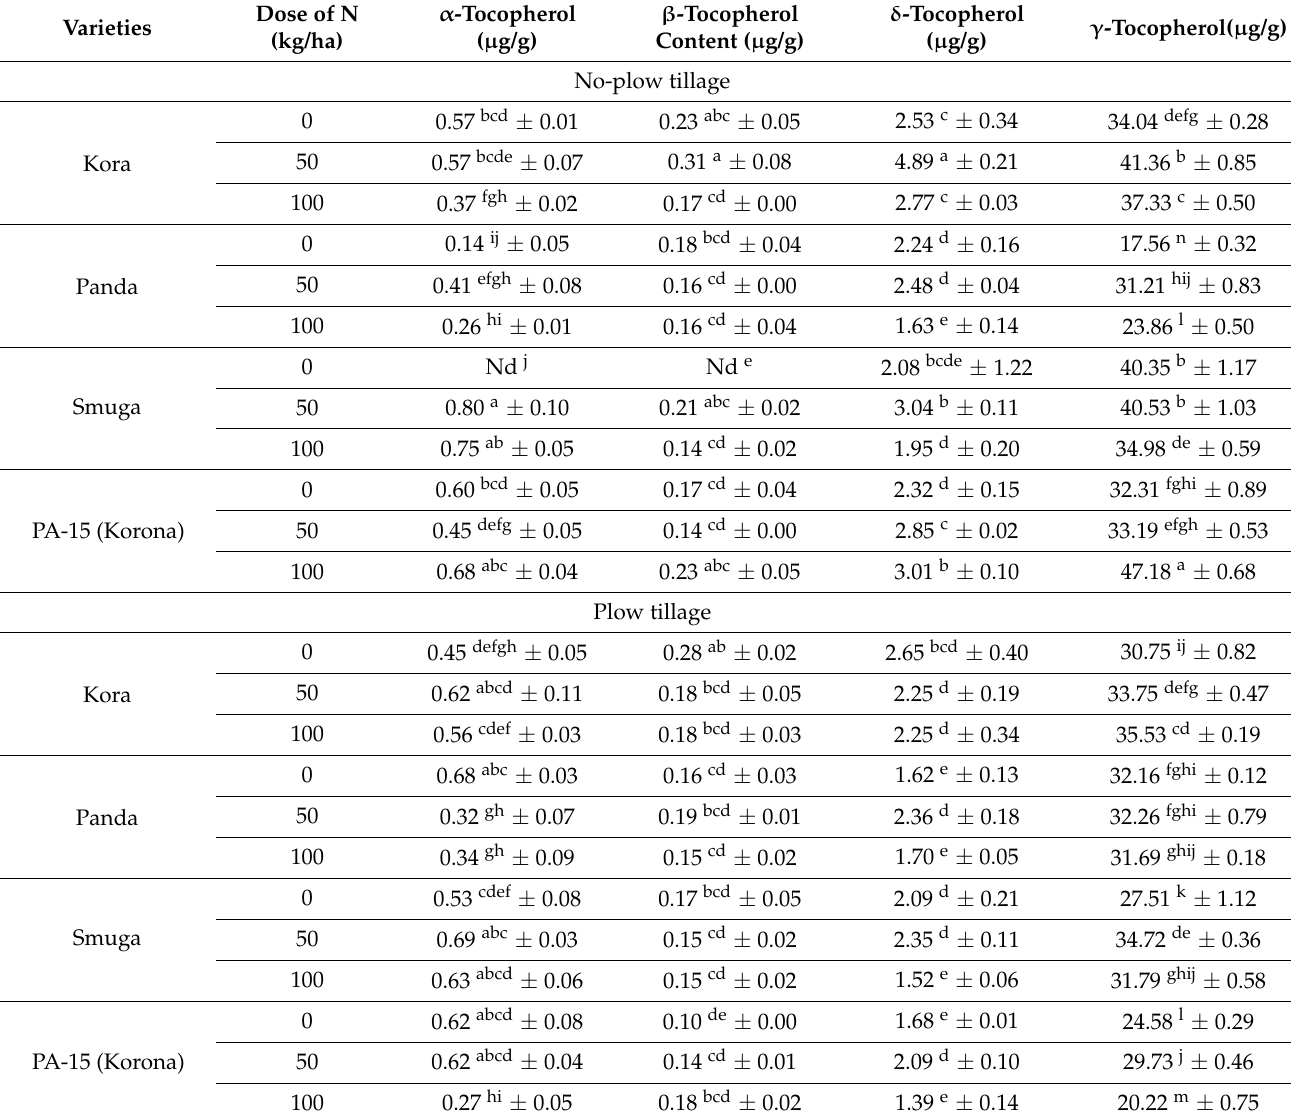
Table 3. α -Tocopherol, β -tocopherol, δ -tocopherol, and γ -tocopherol content for four varieties of no-plow tillage and plow tillage common buckwheat, by fertilization